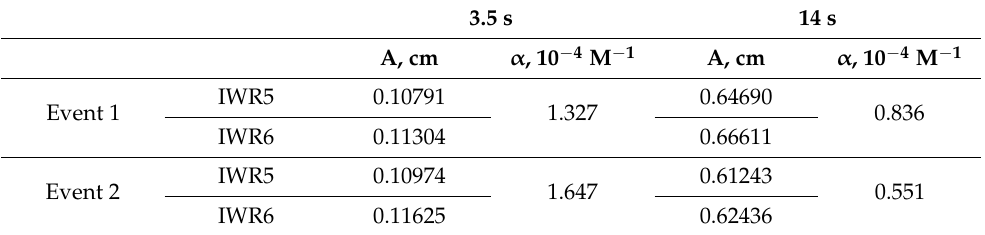
Table 1. Wave amplitudes and attenuation coefficients for 3.5 and 14-s waves for wind Event 1 and Event 2. Amplitude is computed as half the significant wave height (see text for